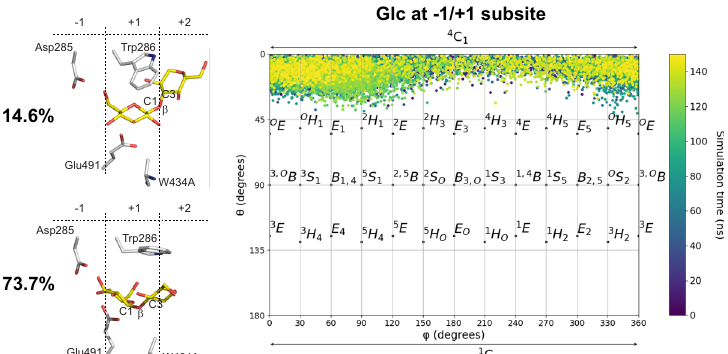
(Mercator projection) of the G3OG product after the − 1 Glc moiety is hydrolysed fromG4OG3OGandremovedfromthe − 1subsiteinW434A.Colourgradientsfrom purple at 0ns to yellow at 150ns in Mercator projections are shown. In b , c , respective cluster analyses of trajectories (populations in %) indicate two modes of G3OG binding in WT and W434A, where each saccharide binds in the +1 and +2 subsites or Glc moieties bind in intermediary positions between those subsites and the − 1